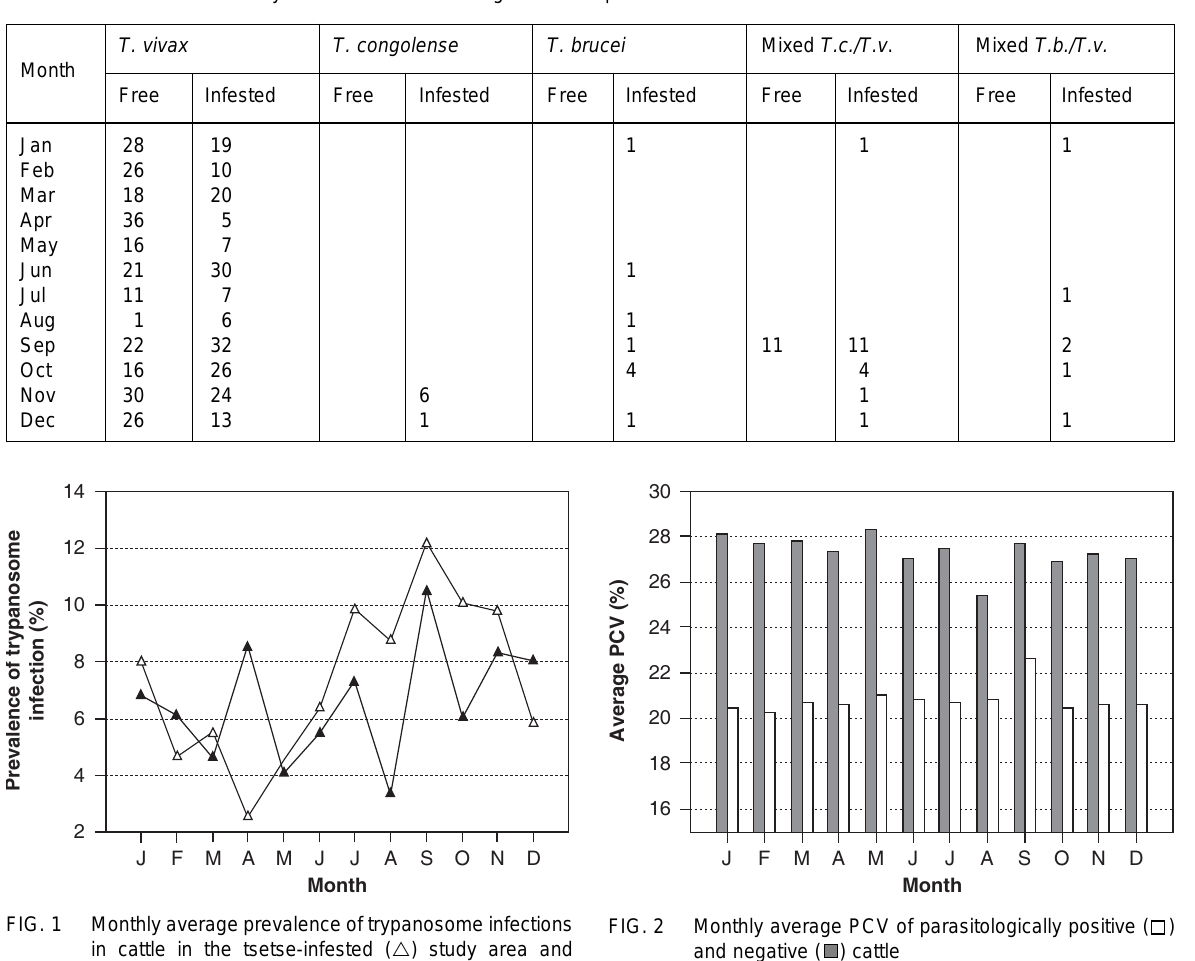
FIG. 1 Monthly average prevalence of trypanosome infections in cattle in the tsetse-infested ( (cid:85) ) study area and tsetse-free ( (cid:83) ) study area of the Amhara Region of north western Ethiopia